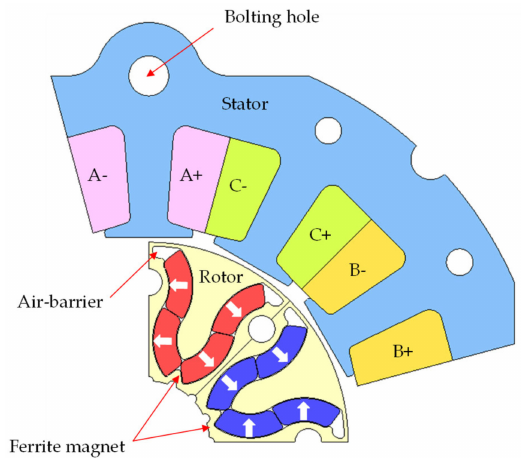
Figure 7. Structure of the proposed flared ferrite IPM model (1 / 4 model).